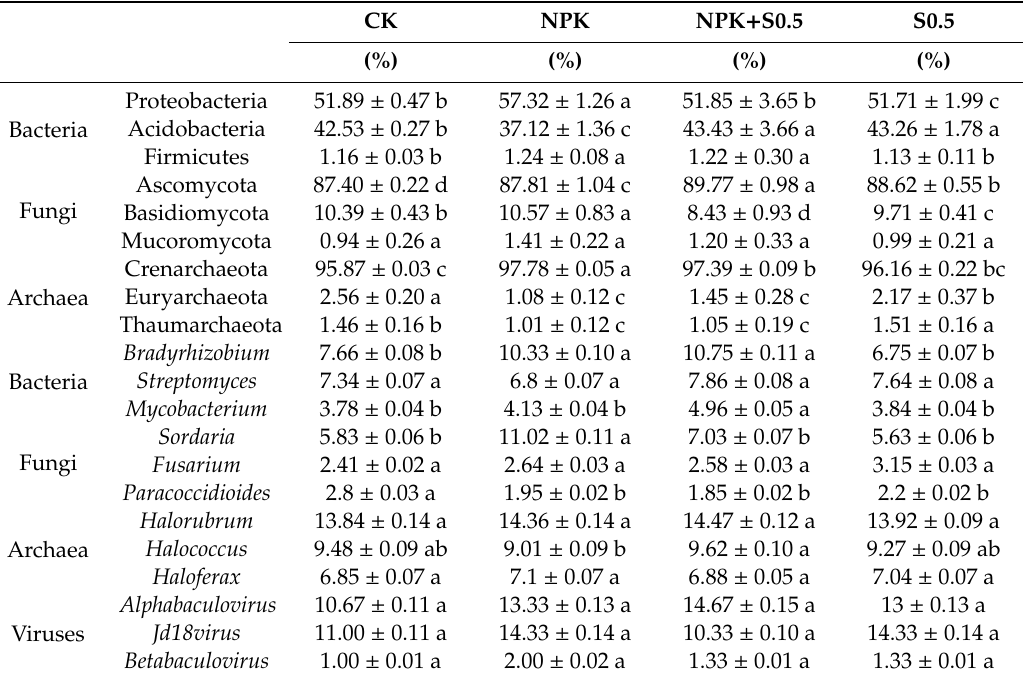
Table 2. Dominant microbiomes at the phylum and genus taxonomic